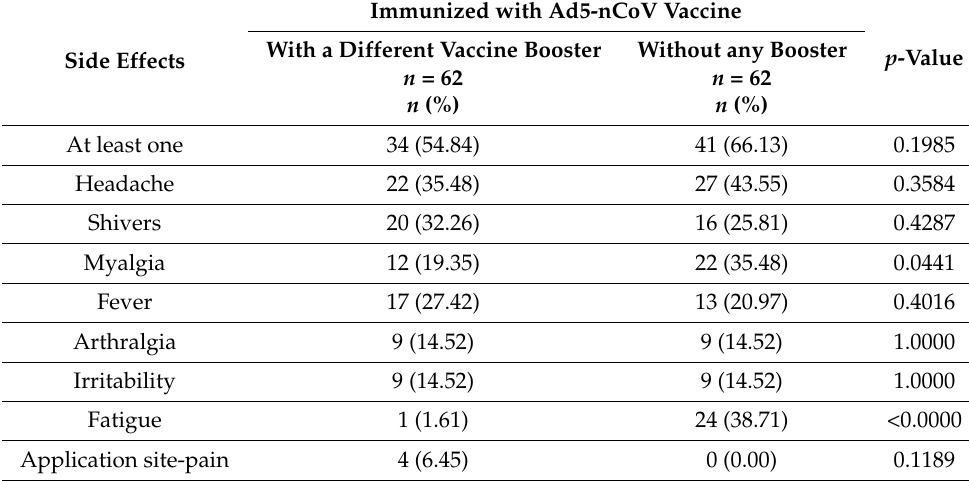
Table 3. Associated side effects comparison with booster presence.